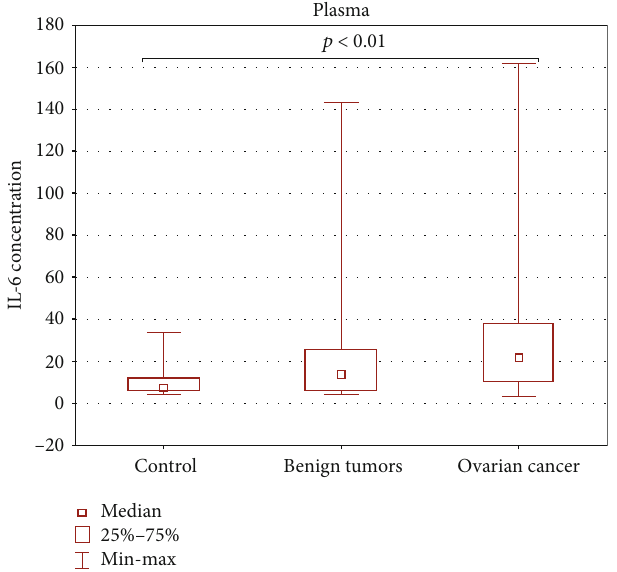
Figure 2: Concentration of IL-6 in the plasma of patients with ovarian tumors and healthy donors.